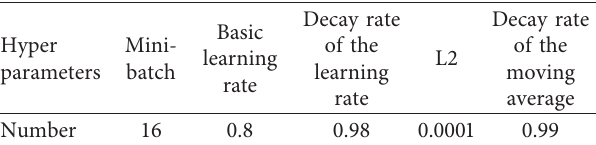
Table 5: Hyperparameters of the girder bridge and arch bridge